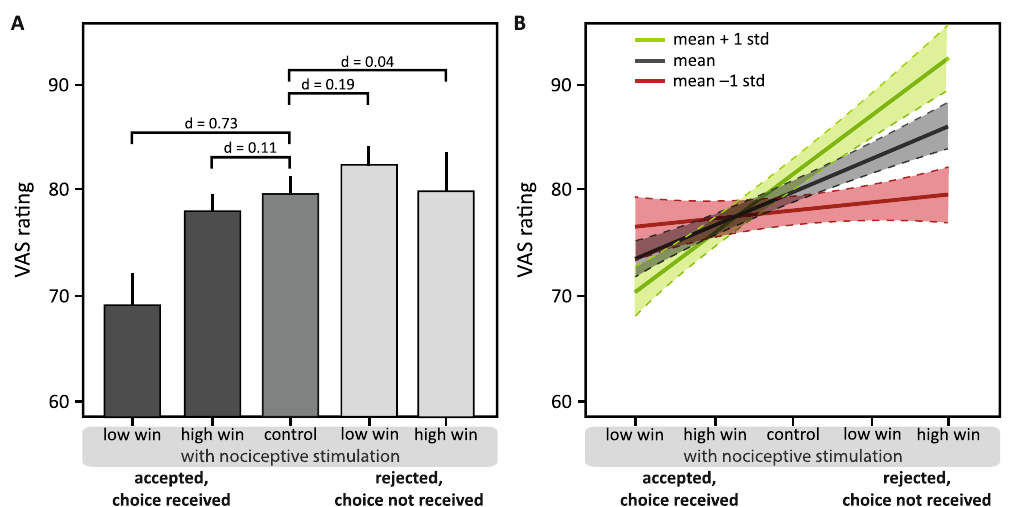
Figure 3. Perception of the nociceptive stimuli in win trials. ( A ) Means and 95% confidence intervals of VAS ratings in the five conditions with nociceptive stimulation: accepted and received with low win, accepted and received with high win, control condition, rejected and not received with low win, rejected and not received with high win. Post-hoc comparisons: effect size indicated by Cohen’s d. ( B ) Effects of subjective utility as a moderator are depicted by regression lines with 95% confidence intervals of estimated VAS ratings at below average (mean − 1 standard deviation; green), average (mean; grey), and above average (mean + 1 standard deviation; red) values of the utility index. The higher the values of the utility index, the higher the participant’s tendency to accept a win and a nociceptive stimulus and the stronger the perceptual